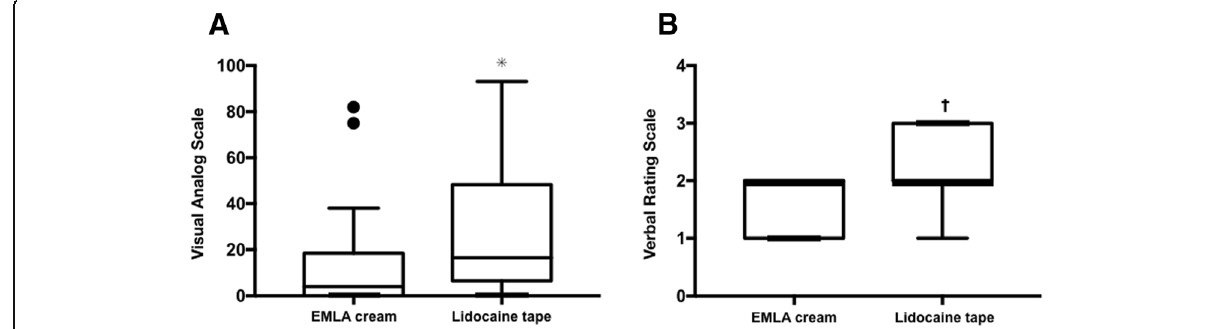
Fig. 2 Comparison of pain intensities between EMLA cream and lidocaine tape. a Visual analog scale scores for pain during venous cannulation. * p = 0.001. b Verbal rating scale scores for pain during venous cannulation. † p = 0.002. Data are presented as median [interquartile range]. EMLA eutectic mixture of local anesthetics